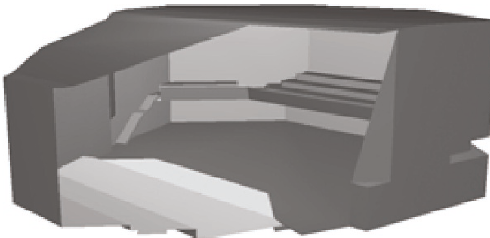
Figure 12: Sliced polygon model of the concert hall of Aachen’s Eu- rogress convention center.